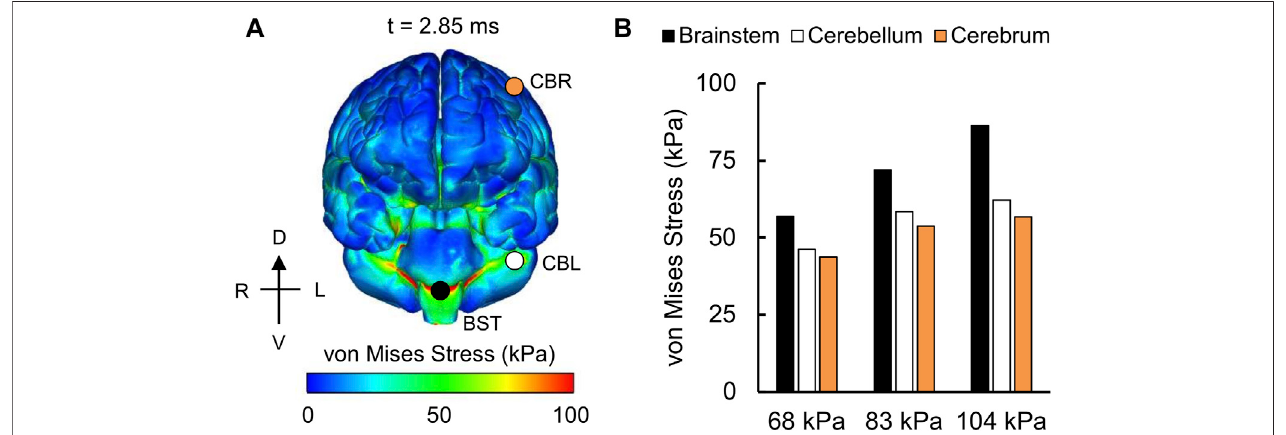
FIGURE5| SimulationshowingthevariationofthevonMisesstressasafunctionofbrainlocation. (A) Contourmapshowingthemodel-predictedvonMisesstress distribution throughout the outer surface of the brain for the 104 kPa blast overpressure at t (cid:1) 2.85 ms into the simulation. CBR: cerebrum (orange circle); CBL: cerebellum(whitecircle);BST:brainstem(blackcircle). (B) BargraphcomparingthepeakvonMisesstressesforthe68,83,and104 kPablastoverpressures.D:dorsal; V: ventral; R: right; L: left.